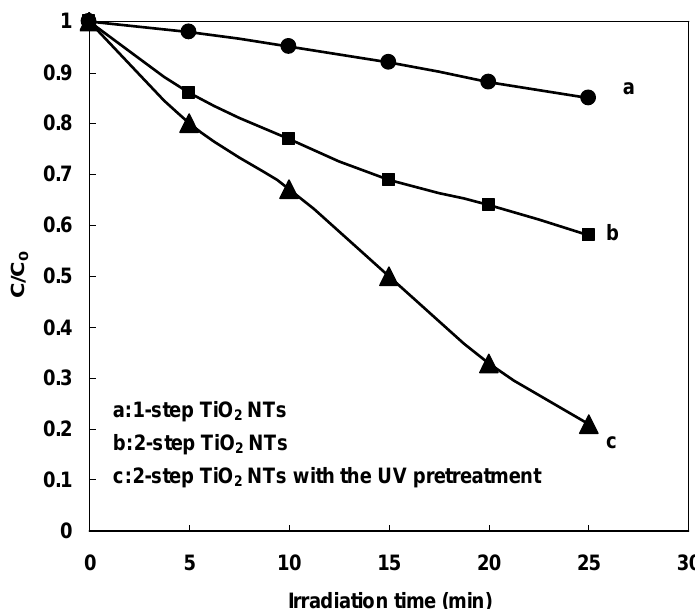
Fig. 5. Comparison of photo-catalytic activity of the samples prepared at various conditions for the photo- catalytic degradation process of salicylic acid.